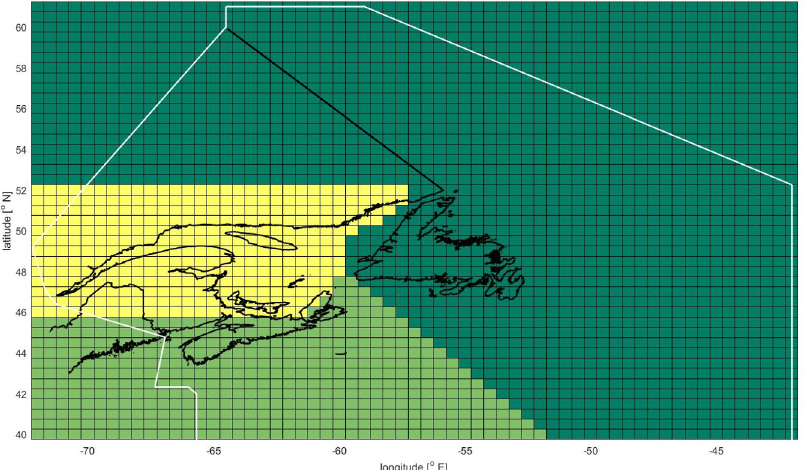
Fig 3. Geographic coverage of datasets. Grid lines indicate individual half-degree latitude/longitude data cells. White boundary line outlines study area (i.e., Canadian Atlantic EEZ). Data outside of this boundary was truncated from the datasets before aggregating management area data. Cell colours define data aggregation layer for DBEM outputs: Newfoundland and Labrador management area is represented by dark green cells; Maritime management area is represented by light green cells, and Gulf (including Quebec) management area is represented by the yellow-green cells. Inclusion of land area within data aggregation is irrelevant, as these cells do not contain any data. Coastline data from: